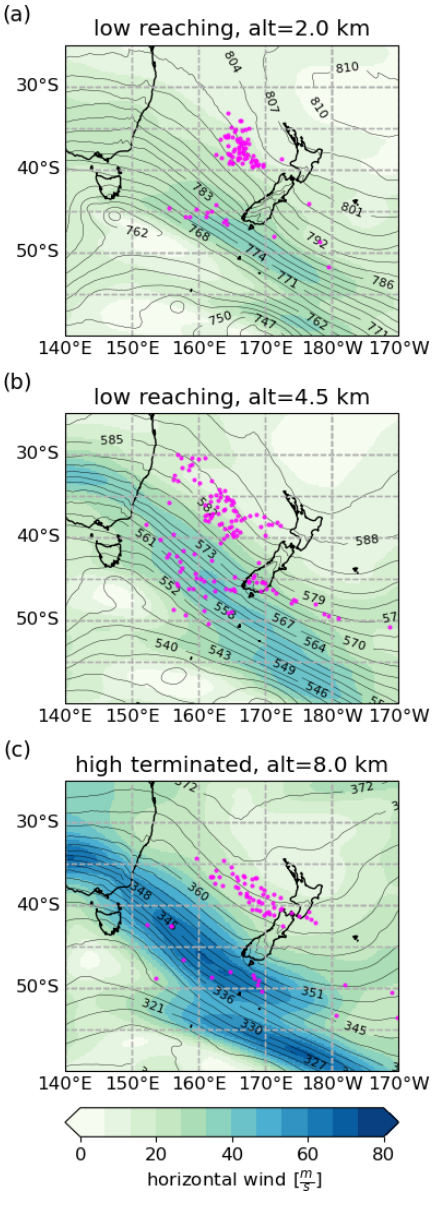
Figure 11. Current ray locations on horizontal background wind maps (i.e. large-scale part from the scale separation) from ECMWF operational analyses of 31 July 2018 at 18:00UTC signified by the colour code. Contours show the pressure levels with values specified as numbers on the